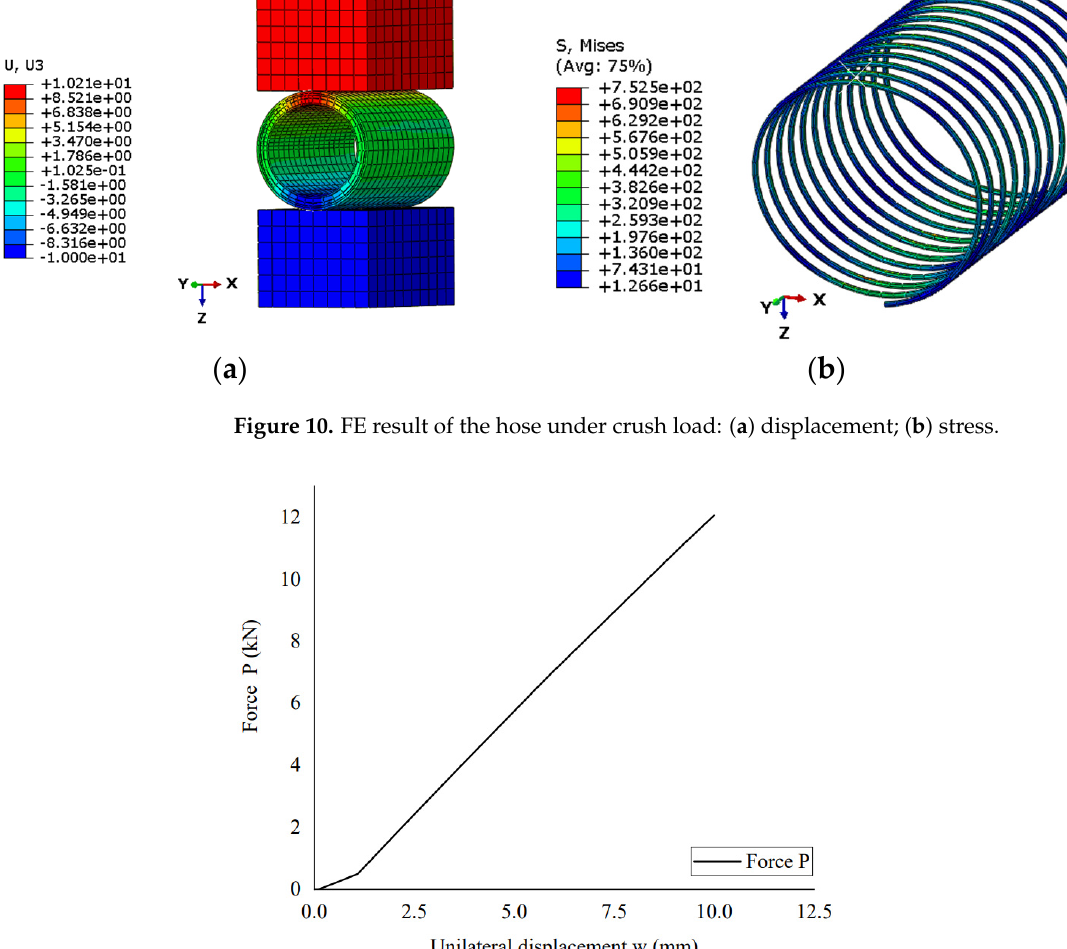
Figure 11. Calculated load ‐ displacement relationship with the FE model.